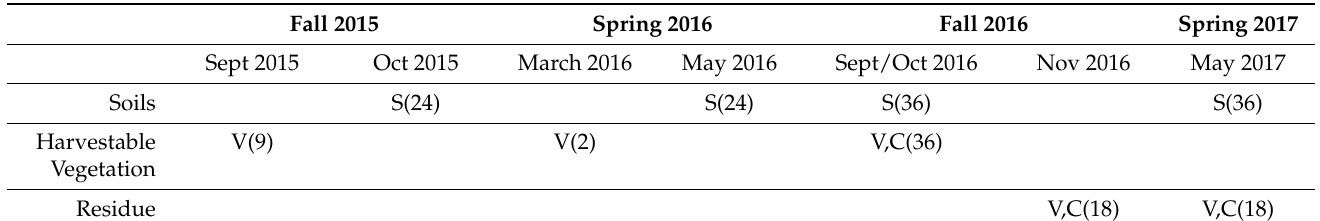
Table 1. A description of soil and vegetation samples collected throughout the duration of the study. In soils, S denotes presence of a sample being taken. In harvestable vegetation and residue, V denotes a sample taken from VFS and C denotes a sample taken from control strips, and the number in parenthesis denotes the number of samples collected on that sampling